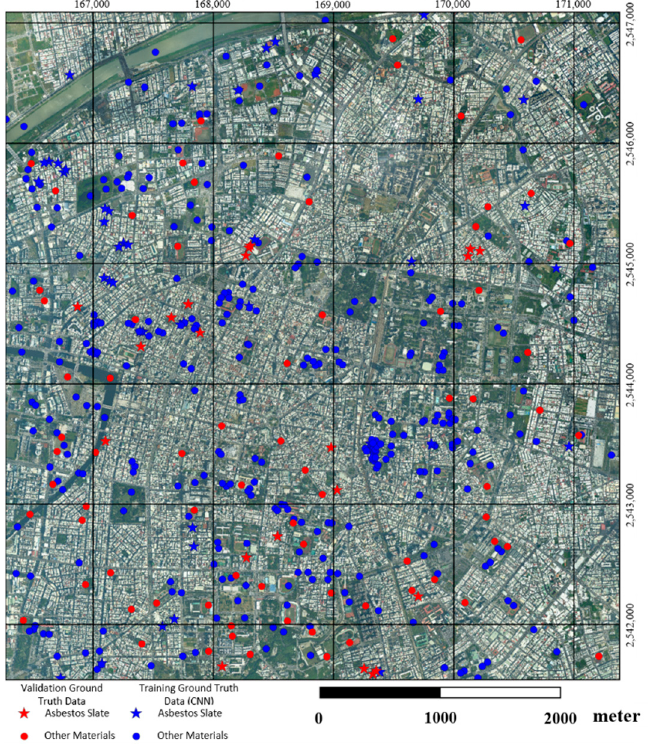
Figure 9. Distributed location of training and validation points for CNN.